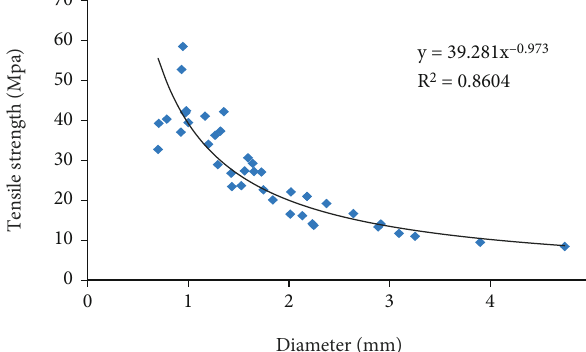
Figure 6: Relationship curve between root tensile resistance and diameter of A. fruticose. Figure 7: Relationship curve between tensile strength and diameter of A. fruticosa root